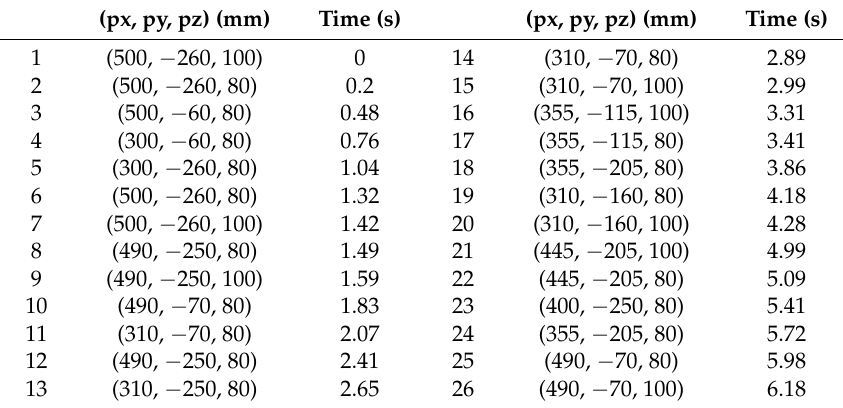
Table 3. The coordinates and time stamps of the via